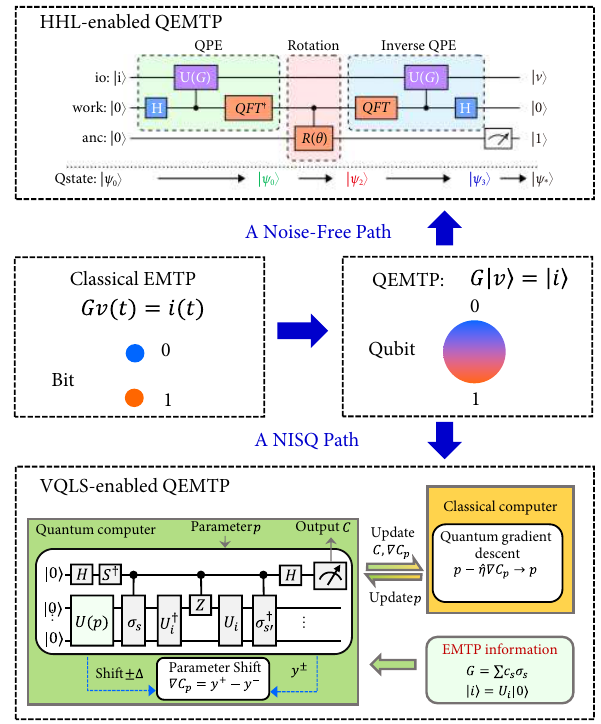
Fig. 3 Schematic of quantum-enabled power system electromagnetic tran- sient analysis [14, 15]